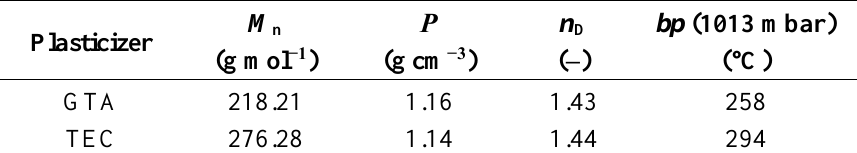
Table 1. Main characteristics of glycerol triacetate and triethyl citrate.